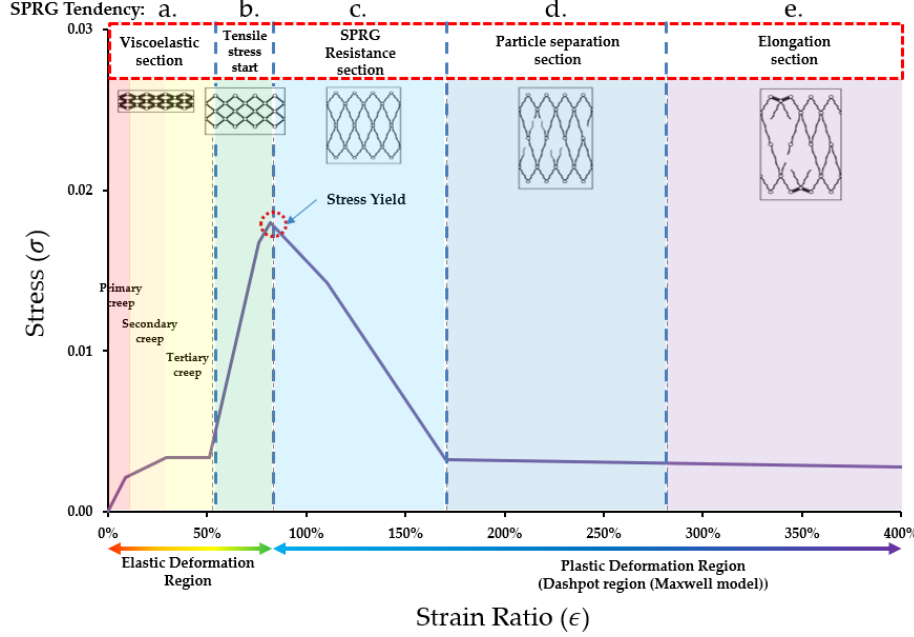
Figure 7. SPRG Stress-Strain curve proposal (tentative).